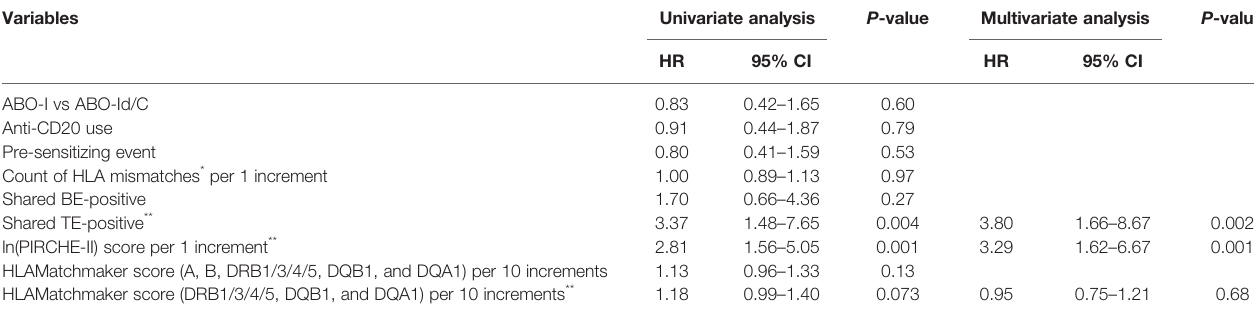
TABLE 4-1 | Cox proportional hazards models of factors associated with dnDSA production in 3 years (n = 38). Variables